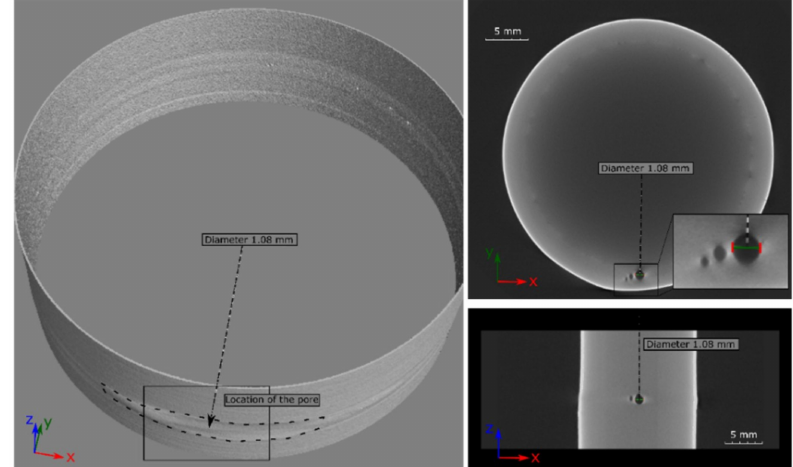
Figure 10. Projections of the computed tomography (CT) image for a laser beam-welded specimen IN625_WOHT_SLME classified to quality group C.